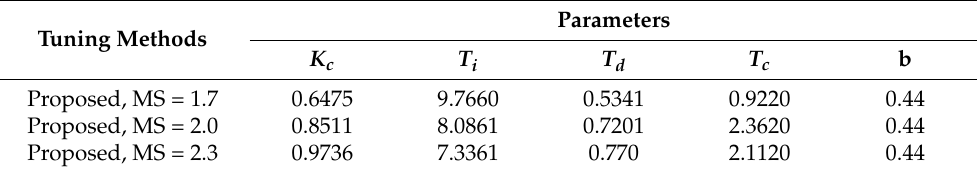
Table 11. Parameter tuning for process P 2 , according to MS values.